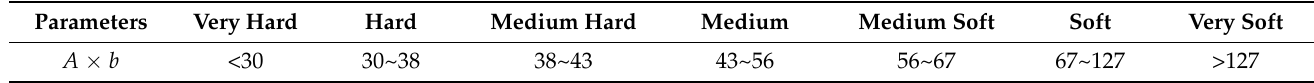
Table 2. The relationship between experimental parameters and ore properties.